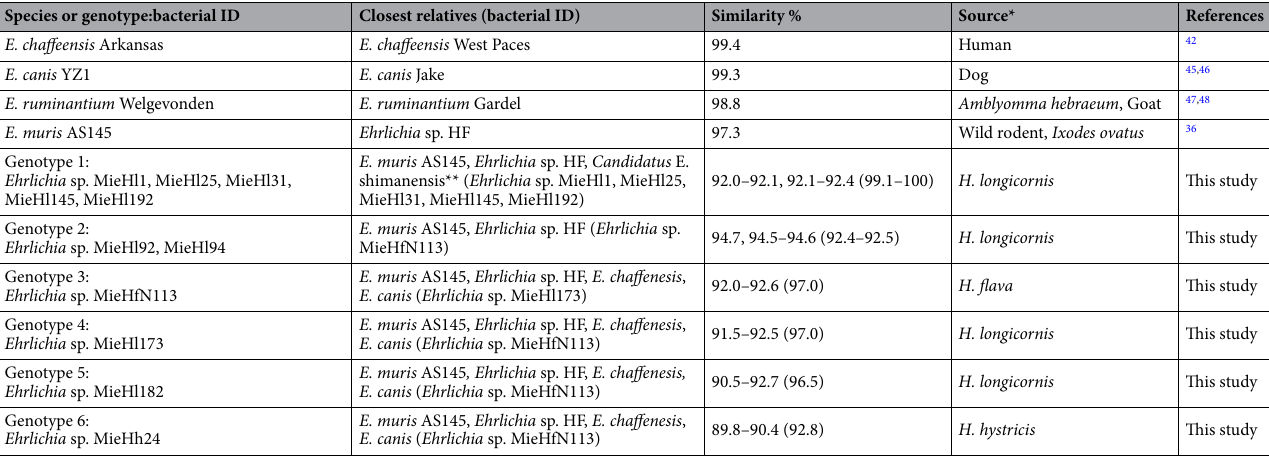
Table 4. Genotypes of uncultured Ehrlichia bacteria in the current study based on the similarities of the core-partial-RGGFR alignment. Under consideration based on the bacterial species criteria (96.8%) due to core genome alignments as previously described 7 , the 11 uncultured Ehrlichia members could be divided into six genotypes, probably including novel Ehrlichia species. * H : Haemaphysalis . **Five Ehrlichia members in genotype 1 may belong to “ Candidatus E. shimanensis” that has previously been proposed based on 16S rRNA and groEL 28